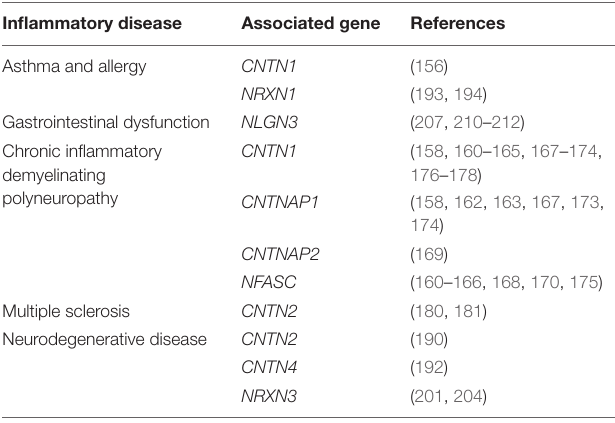
TABLE 2 | Overview of inflammatory diseases and immune disorders that are associated with neuronal cell adhesion